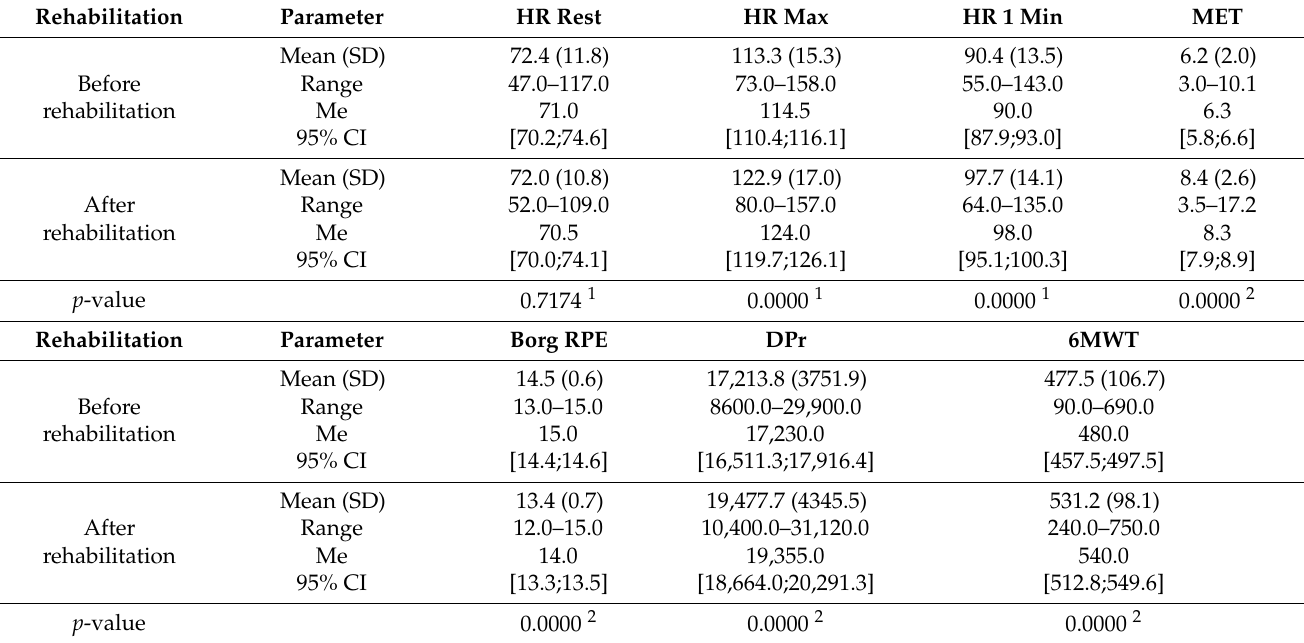
Table 4. Comparative characteristics of the examined CSC-Infarct group in terms of: HR rest